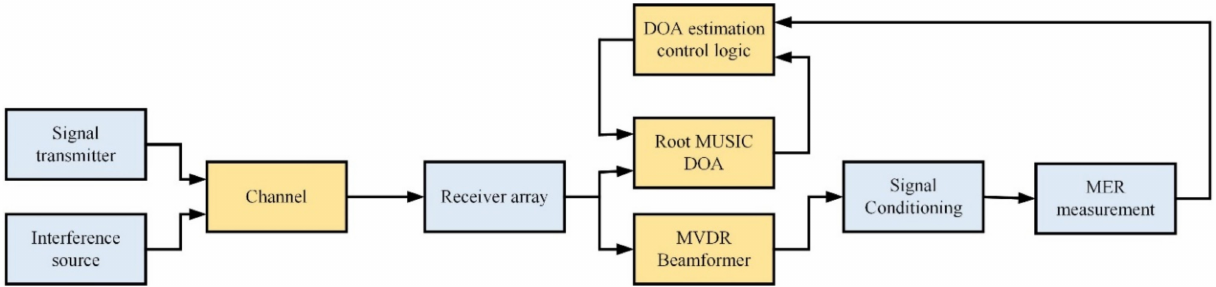
Figure 22. Modeling of Beamforming